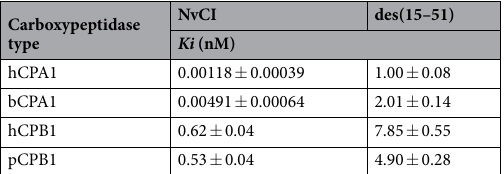
Table 1. Summary of K i values of native and des(15–51) intermediate against various carboxypeptidases. Data are means (n = 3) ± S.D. Inhibition assays were carried out at 37